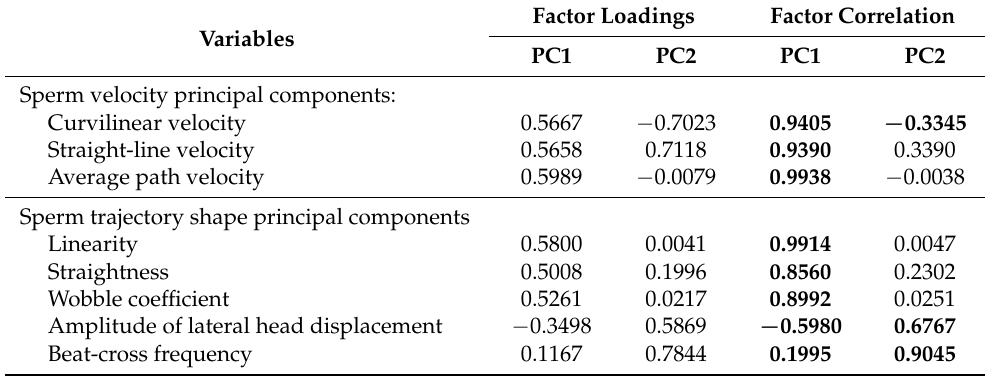
Significant correlation coefficients ( p < 0.05) are shown in bold. PC1: principal component 1.